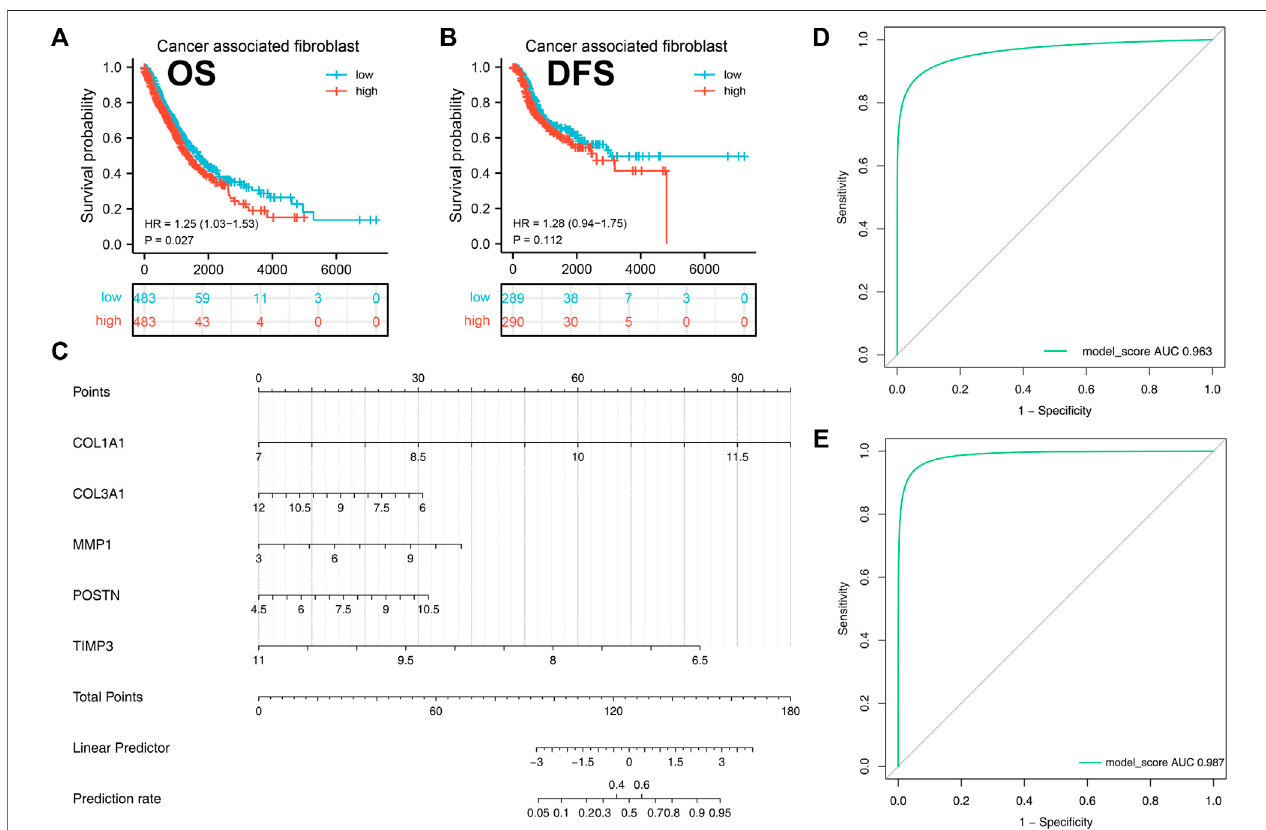
FIGURE 7 | A diagnostic nomogram model was created based on the hub genes and veri fi ed in IPF and NSCLC patients. Notes: (A – B) : Correlation between cancer-associated fi broblasts and patients prognosis(OS andDSS); (C) :Adiagnosticnomogrammodel wasconstructed basedon thehubgenes; (D) :The AUCcurve of the model in predicting the diagnostic value of IPF; (E) : The AUC curve of the model in predicting the diagnostic value of